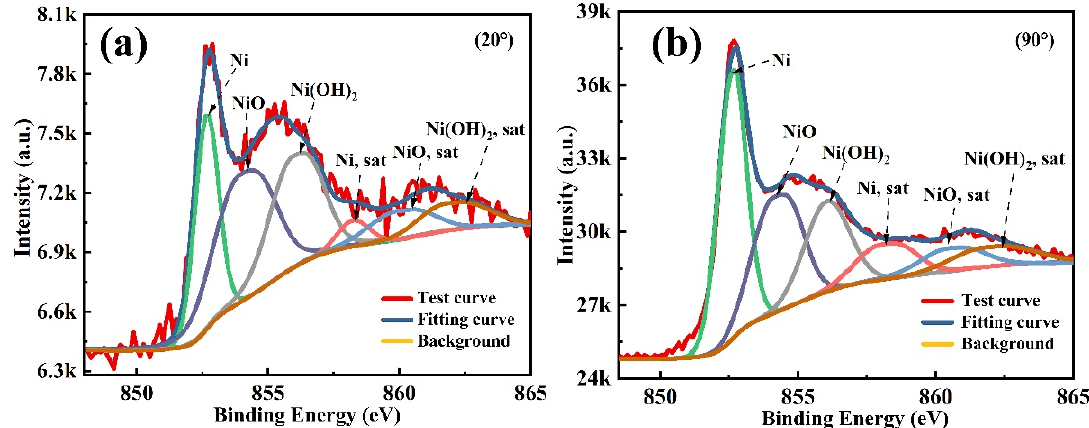
Figure 4. Spectra of Ni 2p photoemission in the NiFe thin film with a thickness of 100 nm at different take-off angles ( α ).